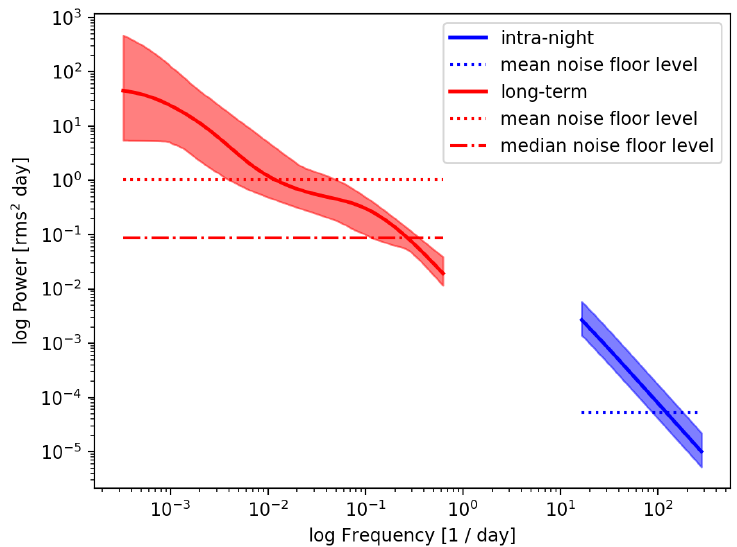
Figure 4. The combined long-term (shown in red color) and intra-night (shown in blue color) PSD from the H.E.S.S. monitoring, extending up to ∼ 6 decades in the temporal frequency range. The shaded area corresponds to the 3 σ confidence regions, and the dashed horizontal lines mark the P stat , for the two